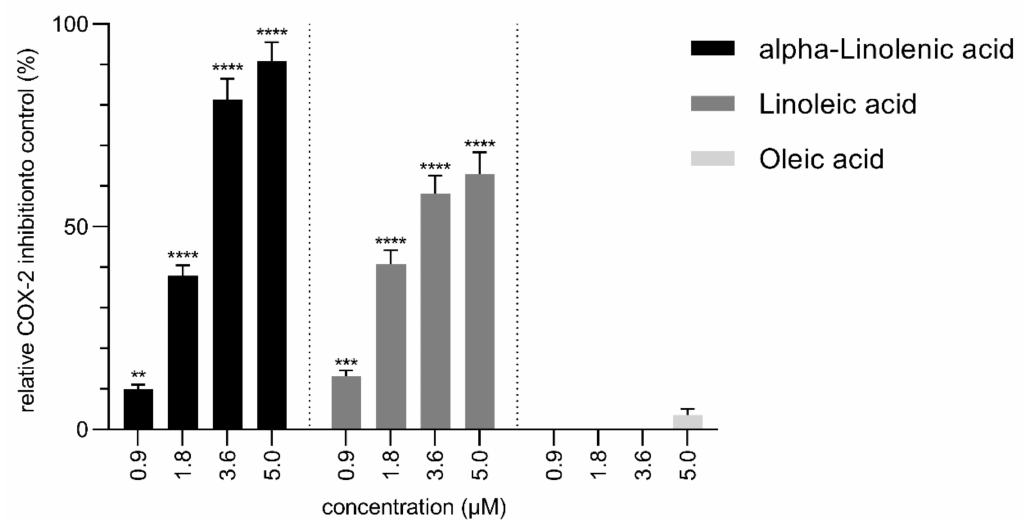
Figure 6. Relative COX-2 inhibition to control (%) of alpha-linolenic acid, linoleic acid and oleic acid with 0.5 µ M celecoxib as control set to 100%. Data points represent the mean value ± standard deviations of six samples. Statistically different expressions were calculated using one-way ANOVA. (****): p < 0.0001; (***): p = 0.0001; (**): p = 0.0029 vs.